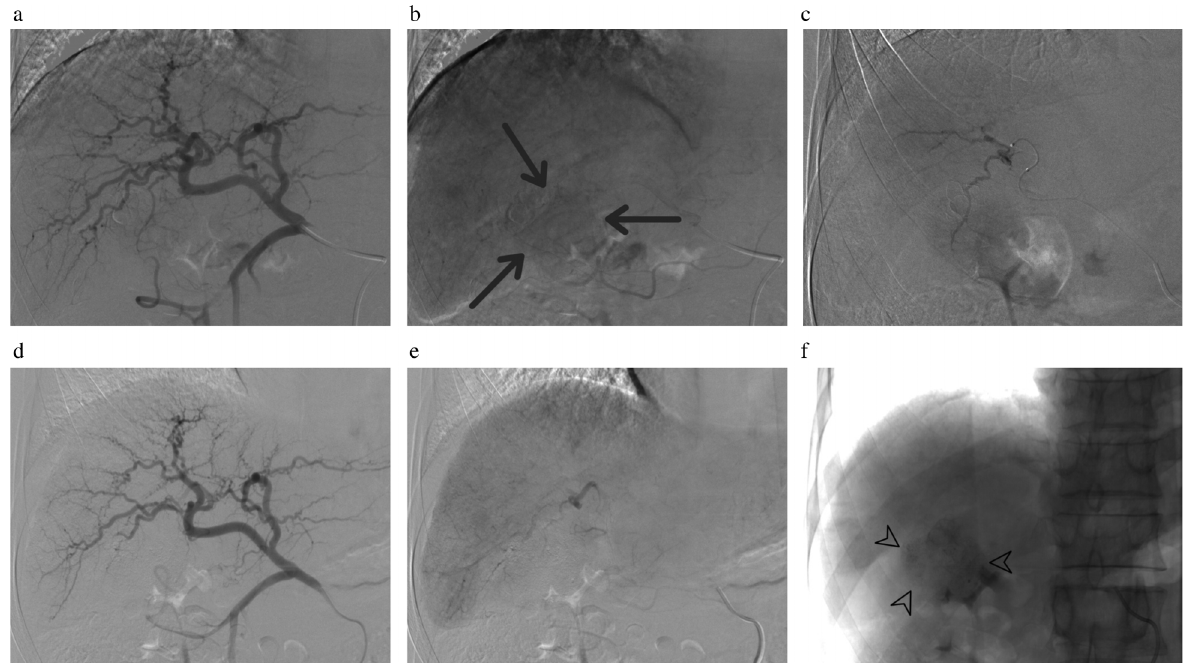
Figure 1 - a-f: cTACE standardization. Selective angiography of the common hepatic artery (a, b) depicts a hypervascular lesion nourished by distal branches of the hepatic artery (arrows). Microcatheters reached the supplying arteries of the tumor (c). No staining of the tumor was seen in the final angiography (d, e). The procedure was considered to be successful. The tumor retained Lipiodol and became radiopaque (f, arrowheads).